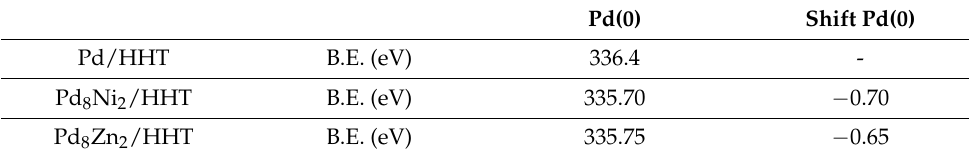
Table 8. Results of the HR spectra for the Pd 3d